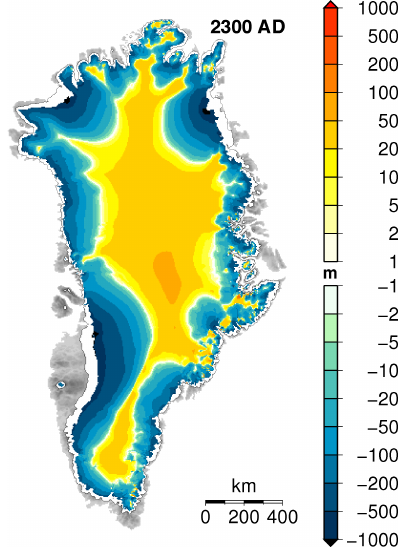
Figure 8. Total ice thickness change by 2300. The initial ice extent is indicated with a black contour line while thickness changes are exclusively shown within the ice extent at the end of the experiment. This particular result for RCP4.5 was obtained with CanESM2, which shows most expressed warming over Greenland for all cli- mate models in the ensemble (Table B1). The thinning patterns for other ensemble members are qualitatively